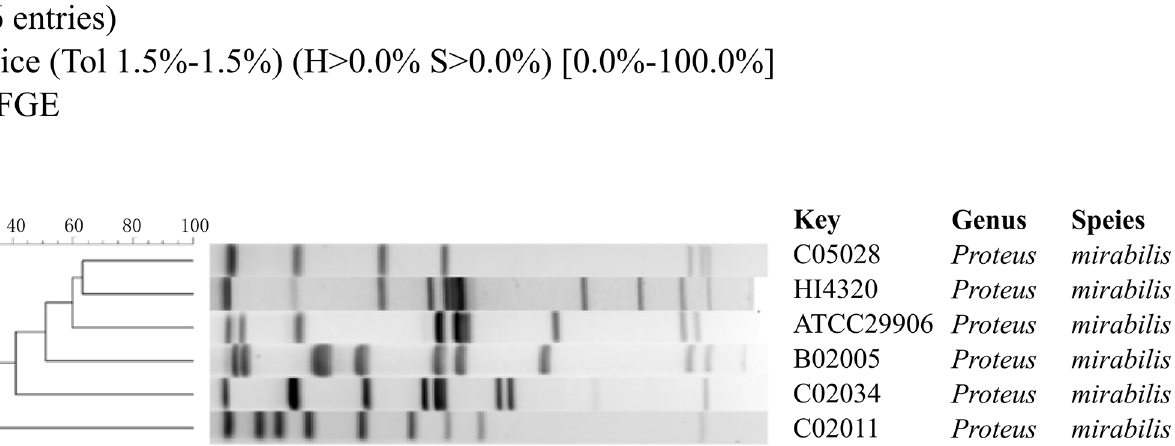
Fig 1. The dendrogram tree of six P . mirabilis strains. Strains C05028 and C02011 are digestion tract infectious. Strains HI4320 and ATCC29906 are urinary tract infectious. Strains B02005 and C02034 are non-infectious strains.